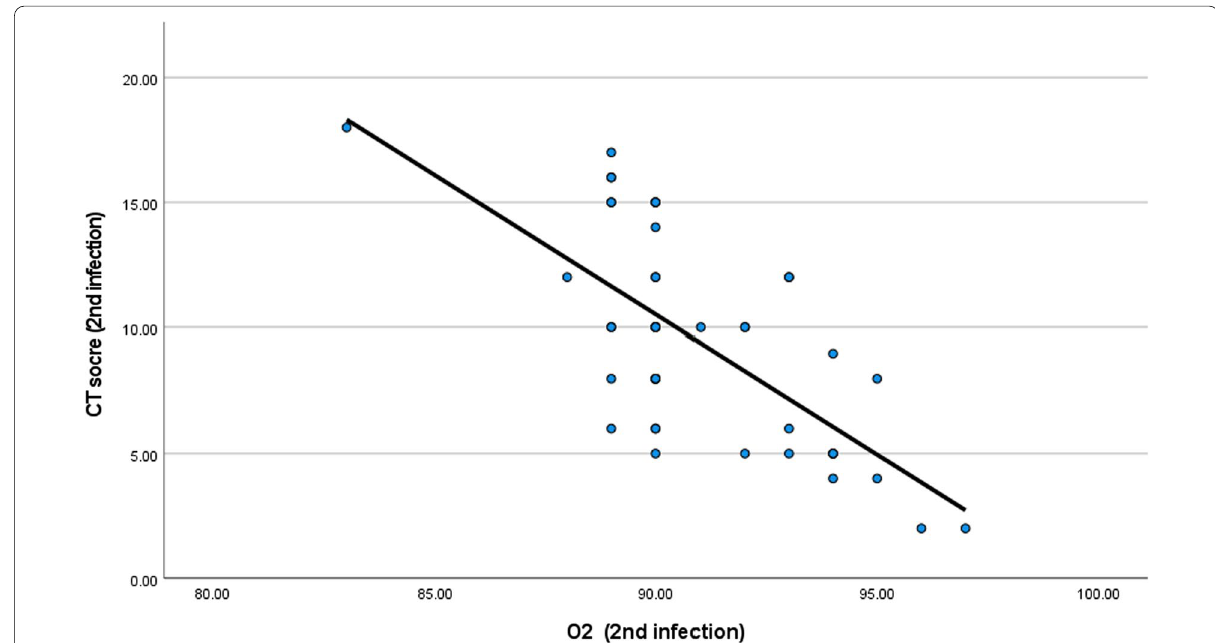
Fig. 9 Relation between CT severity score and O 2 saturation during first